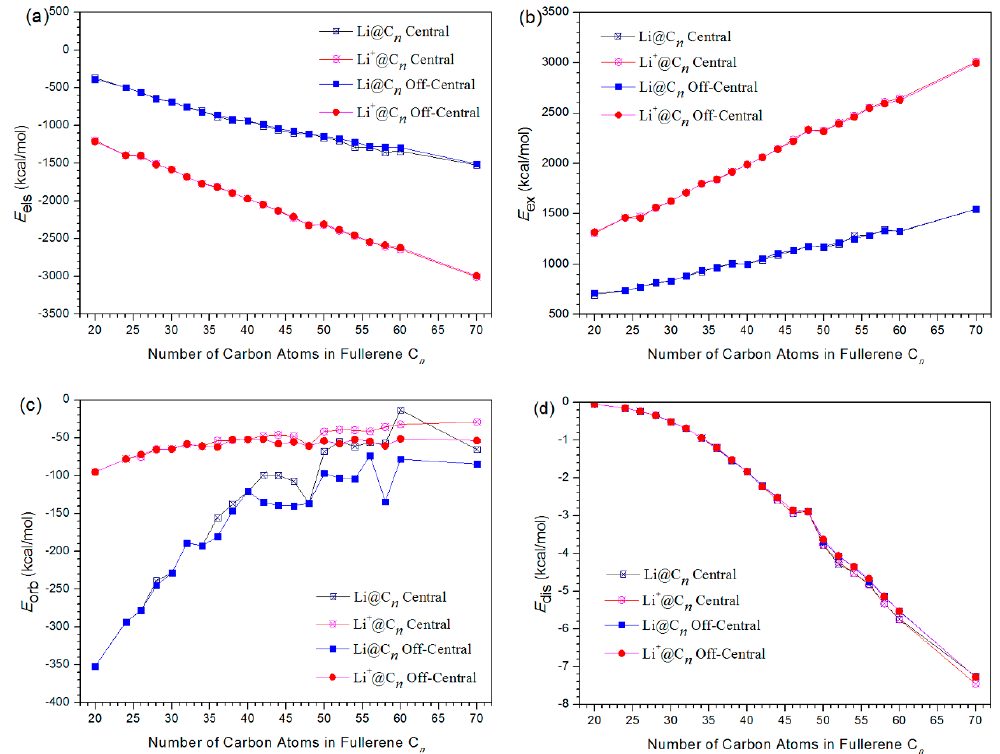
Figure 5. Electrostatic ( a ), exchange ( b ), orbital ( c ) and dispersion ( d ) interaction energies of Li@C n and Li + @C